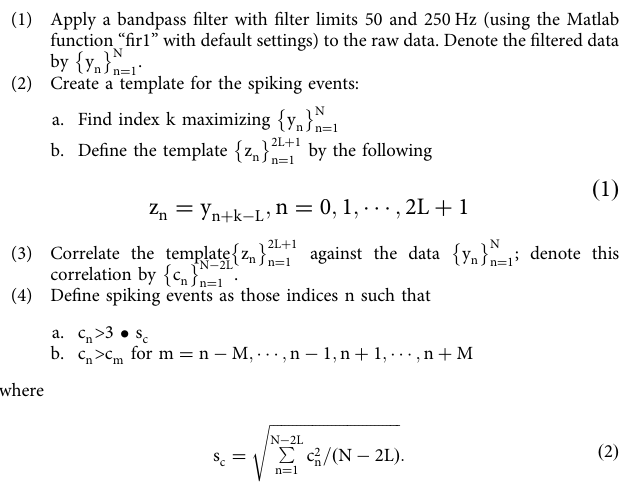
Fig. 8 Effects of tetrodotoxin on spatial coordination of action potentials in colonic smooth muscle. The plots within this fi gure have the same interpretation as those in Fig. 3. In this case, the plots pertain to the analysis of smooth muscle electrical activities during maintained colonic distension with a metal rod, over electrode separation distances from 2 mm and 30 mm. Plot a , l This plot contains the raw data for the proximal and distal colons, represented by the red and blue lines, respectively. Plot b , m This plot contains the WCOH (absolute value) between the proximal and distal colons. In contrast to Fig. 3, there is very little coherence at 2 Hz. For the 2 mm recording, there is coherence at ~0.8 Hz, whereas for the 30 mm recording, there is no coherence between 0-4 Hz. Plot c , d , n , o These plots contain the CWT (absolute value) for the proximal colon and distal colon respectively. In contrast to Fig. 3, the highest activity is between 0.8 and 1.2 Hz, not 2 Hz. Plot e , p The red and blue lines are traces of bandpass fi ltered data ( fi lter limits 0.5 and 3.5 Hz) for the proximal and distal colon respectively. Plot f , g , q , r In both plots, a window (length 3 sec) has been slid over the bandpass fi ltered data in plots e , p . In each window instance, the likelihood that the data has a particular frequency is calculated; these plots display the log-likelihood. The frequency range for which the likelihood is calculated is given by the y -axis — in these examples from 0.5 to 2.5 Hz. Plot h , s These plots overlay the frequency maximizing the log-likelihood function for the proximal (plots f , q ), and distal colon (plots g , r ). For the 2 mm recording, the frequencies maximizing the likelihood functions are both ~0.8 Hz, whereas for the 30 mm recording, there is very little consistency in frequency. Plot i , t : In these plots, a window (length 3 sec) has been slid over the bandpass fi ltered data in plots e , p . In each window instance, the cross correlation between the proximal and distal colons is calculated, which these plots display. In contrast to Fig. 3, there are no periods of high or increased correlation, particularly for the 30 mm recording. Plot j , k , u , v : In these plots, a window (length 3 sec) has been slid over the bandpass fi ltered data in plot e , p . In each window instance, the auto- correlation function is calculated; plot j , u contains the auto-correlation function for the proximal colon, and plots k , v the auto-correlation function for the distal colon. In contrast to Fig. 3, the auto-correlation functions are not periodic at ~0.5 sec, rather, are weakly periodic between 0.8 and 1.25 sec, which is consistent with the frequency estimates displayed in plot h ,